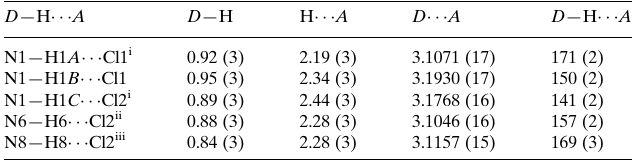
Hydrogen-bond geometry (A˚ , (cid:4)